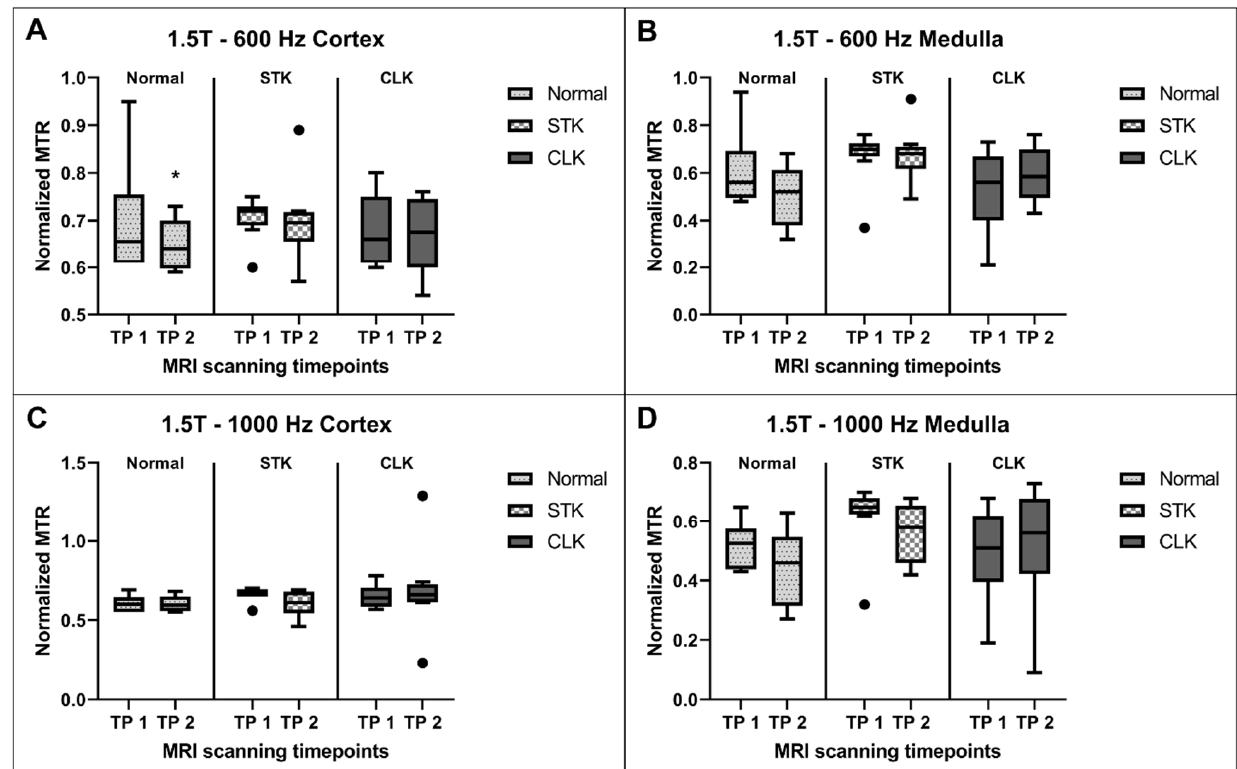
Figure 5. Normalized MTR values compared between the two timepoints (TP) for the normal, stenotic, and contralateral kidneys at 1.5T at 600 Hz offset frequency in the cortex ( A ) and medulla ( B ) and at 1000 Hz offset frequency in the cortex ( C ) and medulla ( D ). * p ≤ 0.05 vs. first TP for the same kidney region.